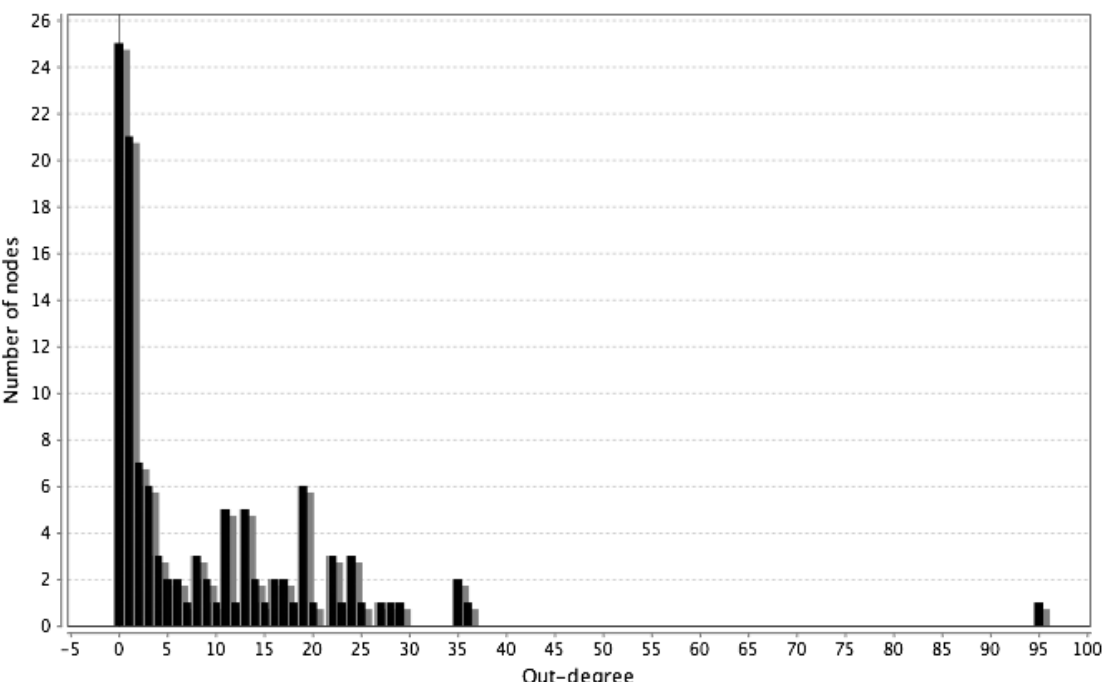
Figure 13 . In-degree (A) and out-degree (B) distribution of all the members in the Books conversational